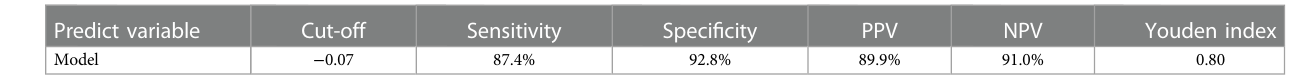
TABLE 3 The ROC curve